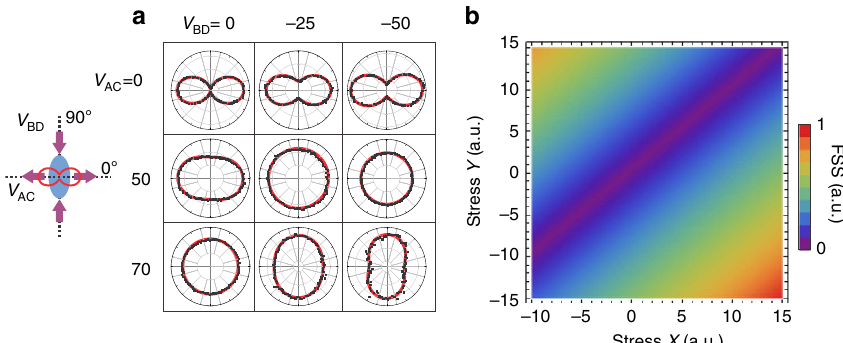
Figure 4 | Semi-quantitative description of the independent tunability of exciton wavelength and FSS. ( a ) Matrix of polarization plots at different voltage combinations. Here the exciton energy is plotted as a function of y , with the same definition being used in the inset of Fig. 2a. All polar plots have an axis scale of 15 m eV, and the solid red lines represent a fit to the data with a sinusoidal function. The ‘circularity’ and the direction of the pedals indicate the relative amplitude of FSS and y , respectively. Circular polarized exciton emission with zero FSS can be observed at three different voltage combinations, that is, at different exciton emission wavelength. No appreciable polarization rotation can be observed at the applied voltages. The schematic shows the stress condition for this type of QDs. ( b ) A density plot of the FSS as a function of the two stress magnitudes X , Y as obtained with the two-level model Hamiltonian. FSS is kept at zero for a range of stress combinations ( X , Y ), therefore the wavelength at which FSS is zero can be tuned